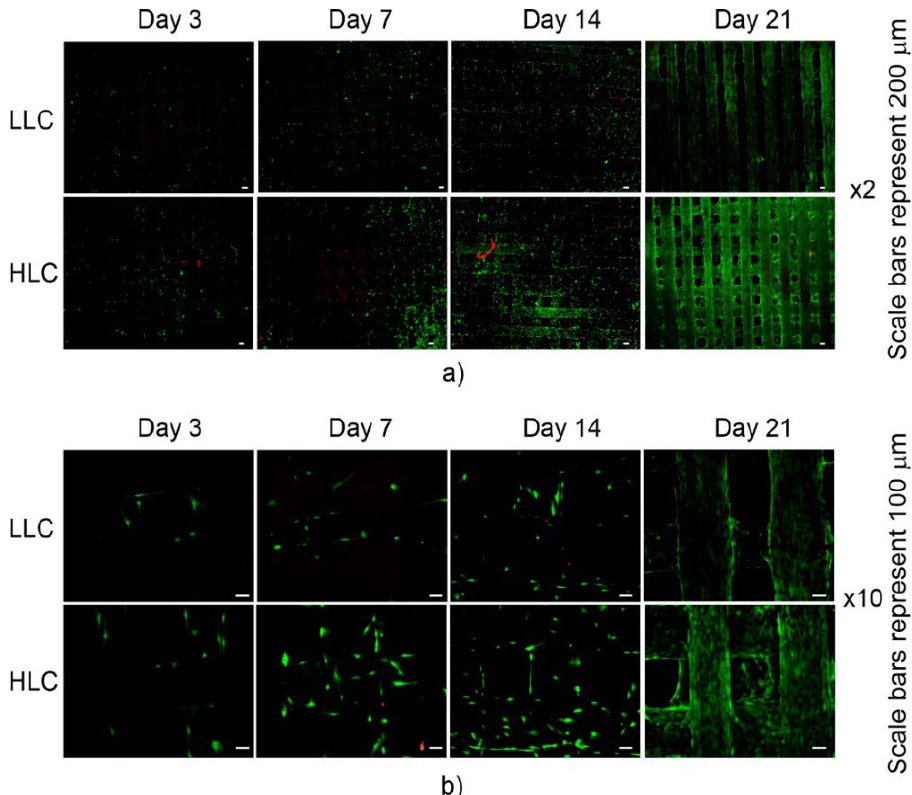
Figure 16. Microscopic images after live-dead assay using fluorescence staining of cells seeded on top of LLC and HLC scaffolds over 21 days at ( a ) lower (×2) and ( b ) higher (×10) magnification.